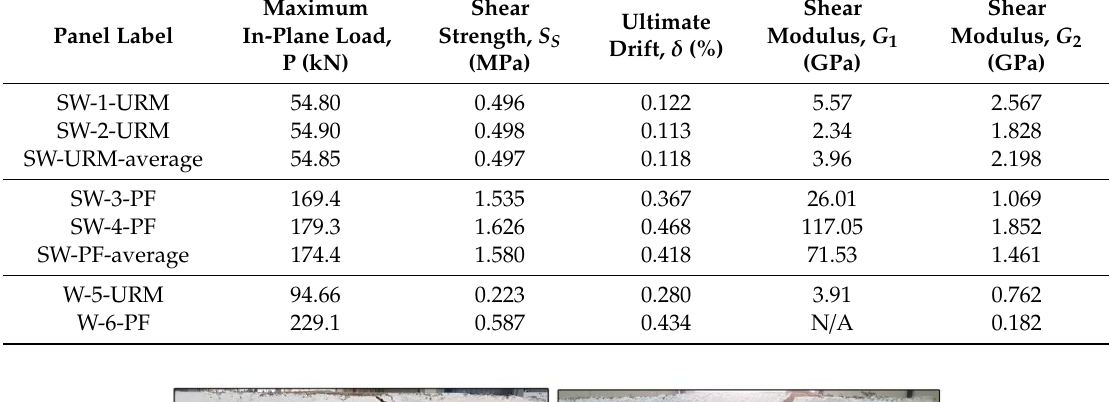
Table 5. Results of the shear tests (diagonal compression tests).